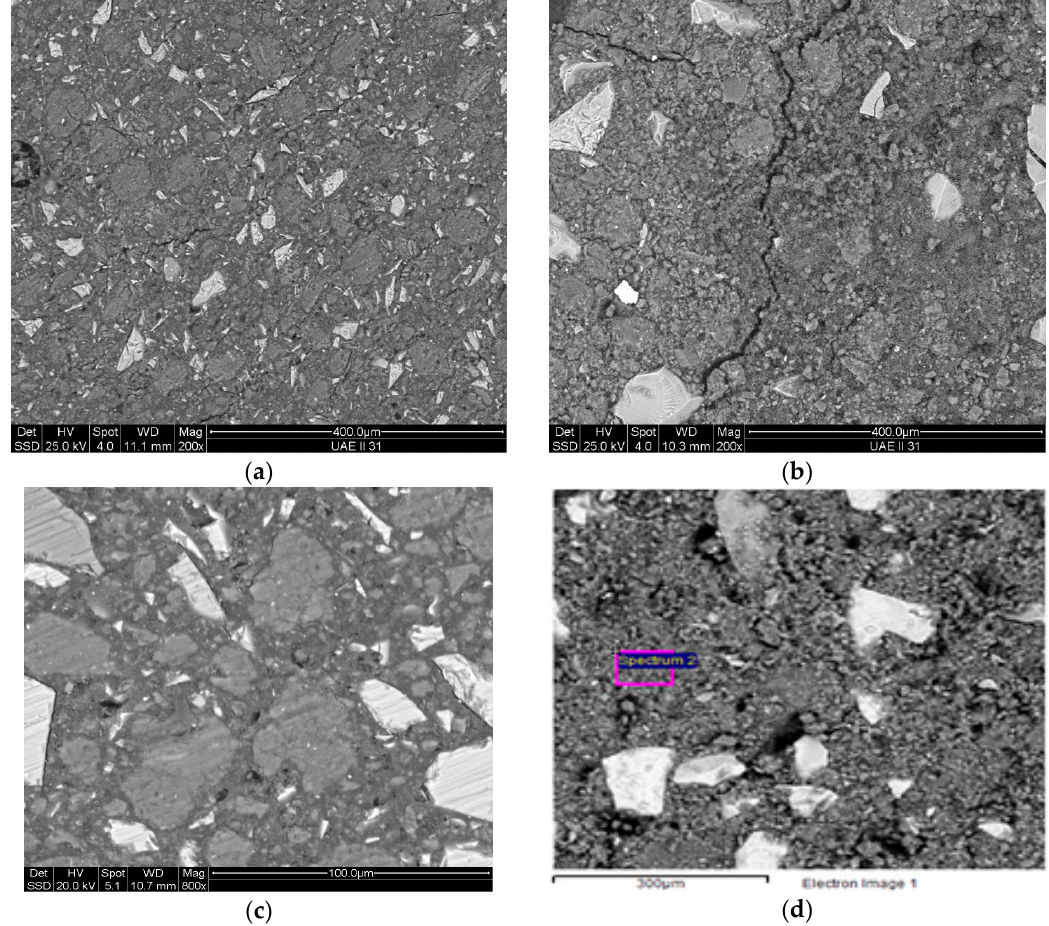
Figure 4. SEM micrographs of geopolymers containing VFNL glass with a grain size ( a ) <45 µ m and ( b ) <125 µ m after a curing time of 14 days; ( c ) <45 µ m 800×; and ( d ) <125 µ m 800×.